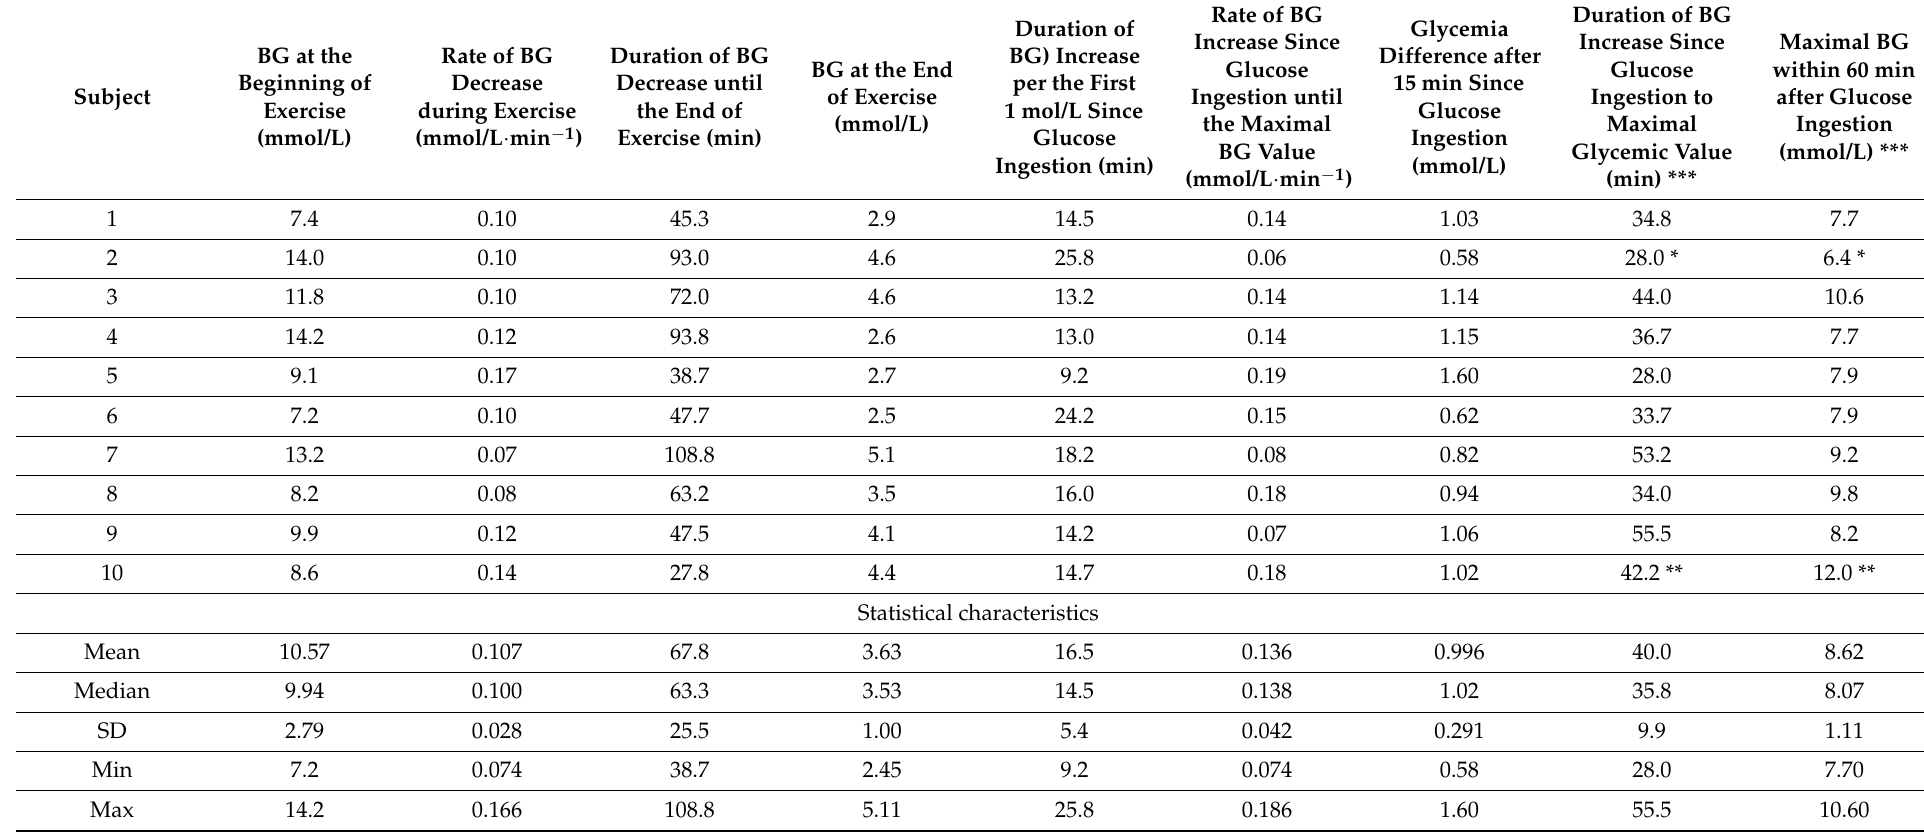
Table 1. Characteristics of blood glucose changes during and after exercise in individual